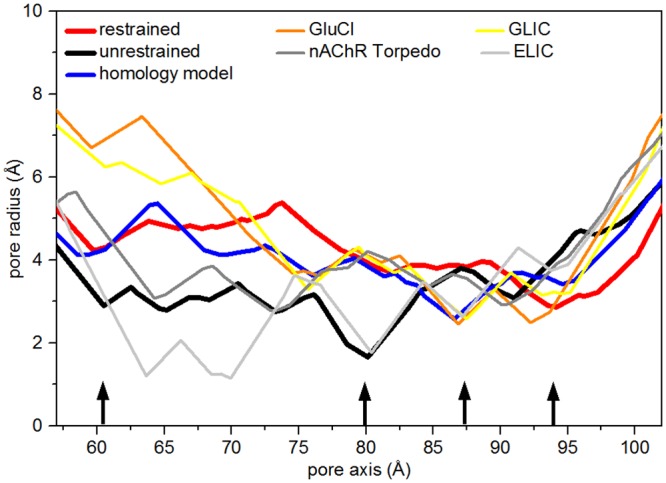
Pore profile.Pore radius profiles along the pore region in the homology model configuration (blue curve), in the collapsed (black) and open (red) structures averaged over the last 100ns of the unrestrained and restrained trajectories, respectively. Also reported the profiles for open channels (GluCl and GLIC from X-rays) and closed channels (Torpedo nAChR from EM and ELIC from X-rays). Pore radius computed with MolAxis [80]. MolAxis is a channel finding algorithm, in which molecular channels are represented using “corridors”, i.e. probable routes taken by a small molecule passing through a channel. MolAxis uses an algorithm that allows fast identification of corridors in the complementary space of the molecule. The black arrows, from left to right, indicate Glu20′, Leu9′, Thr6′ and Gly2′.